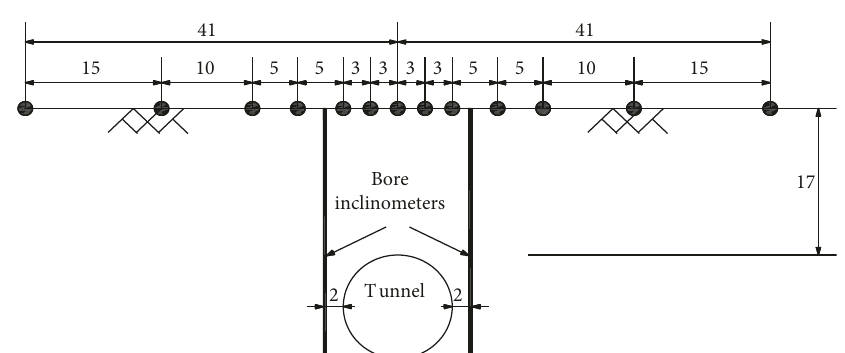
Figure 6: Alignment of the monitoring system in the monitoring section (unit: